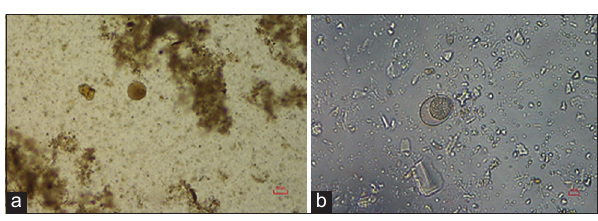
Figure-2: Oocysts present in fighting bull samples. (a) Balantidium coli ; (b) Coccidia spp.